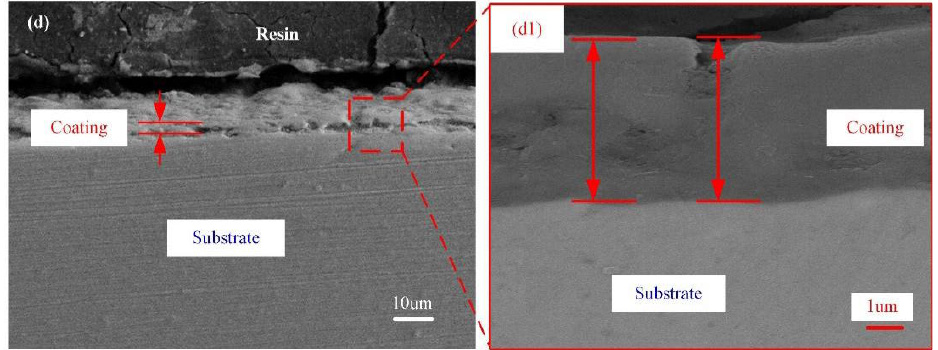
Figure 6. Cross-sectional morphology of PEO-coated samples: Substrate roughness of ( a , a1 ) 3.2; ( b , b1 ) 1.6; ( c , c1 ) 0.8; and ( d , d1 ) 0.2 µm. H 2 and H 1 are the maximum and minimum values of coating thickness,